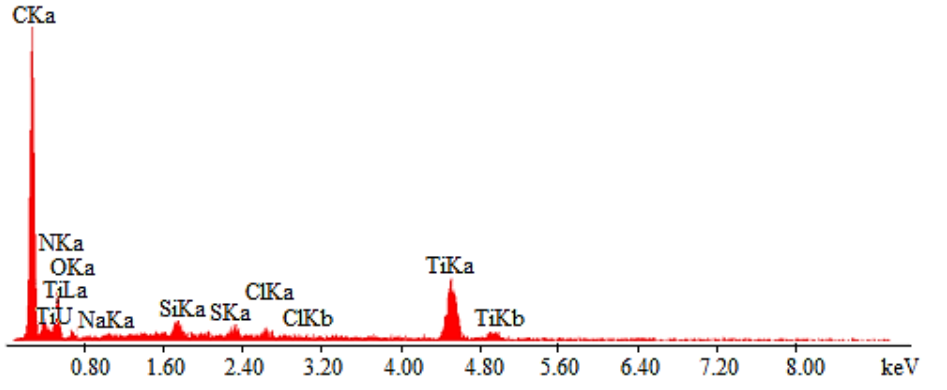
Figure 9. EDS spectrum of element distribution for Ti-Si coated NATAN fabric at point “1” (Figure 8b).